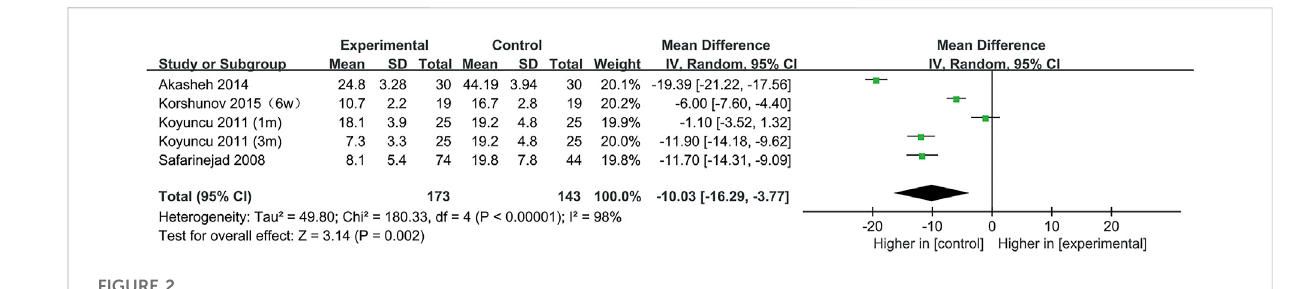
Forest plot for the association between SSRIs used and normal sperm